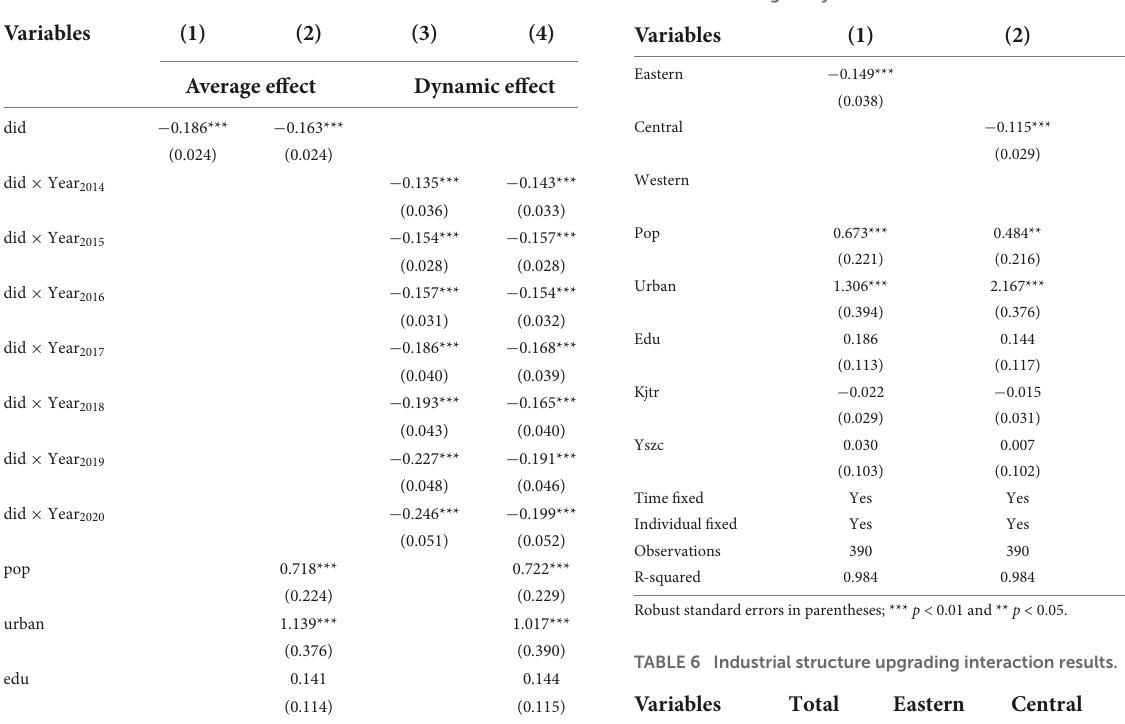
TABLE 4 Baseline estimation results. TABLE 5 Heterogeneity results.